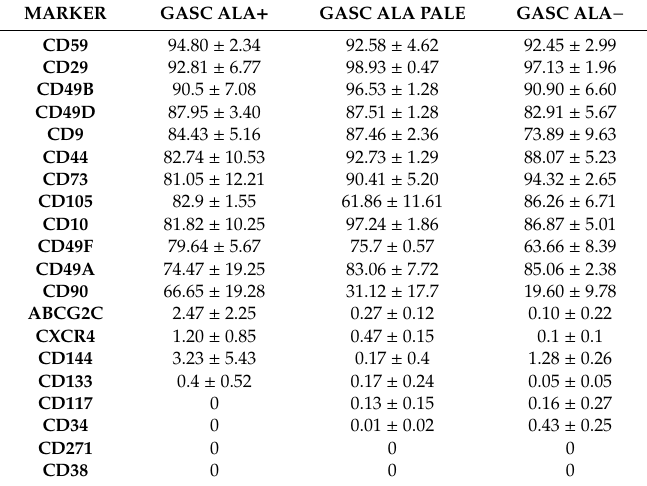
Table 1. Comparative expression of surface antigens evaluated by flow cytometry. The fraction of cells expressing the assayed markers is reported as mean ± SD. GASC-ALA + ( n = 3), GASC ALA PALE ( n = 3) and GASC-ALA − ( n = 3) were analyzed at the third passage in culture.